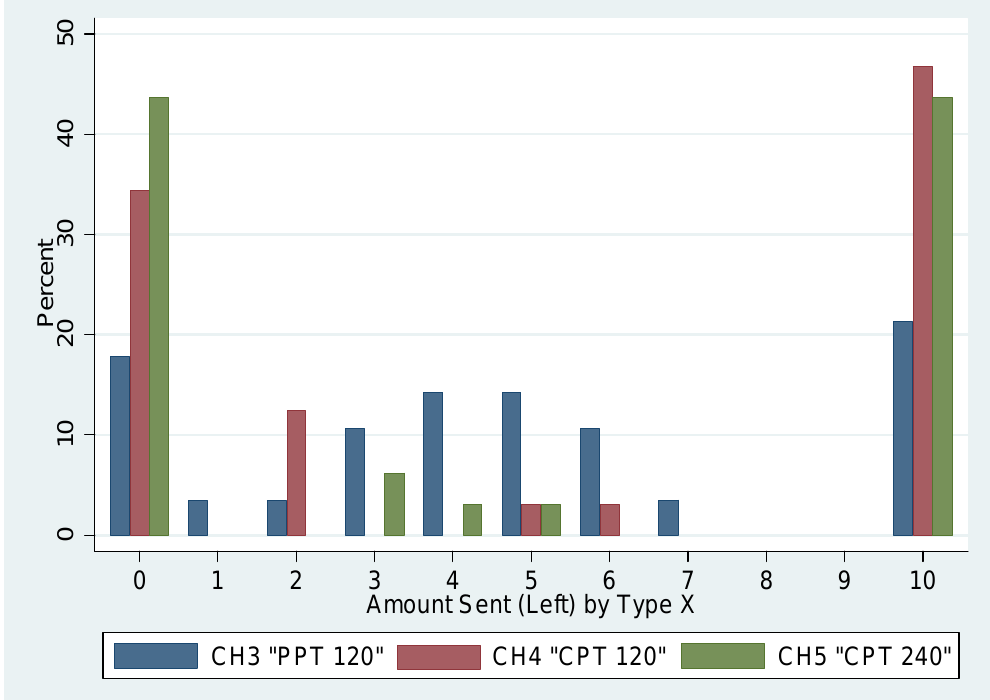
Figure 5. Comparison of Type X data for CH3, CH4, and CH5.